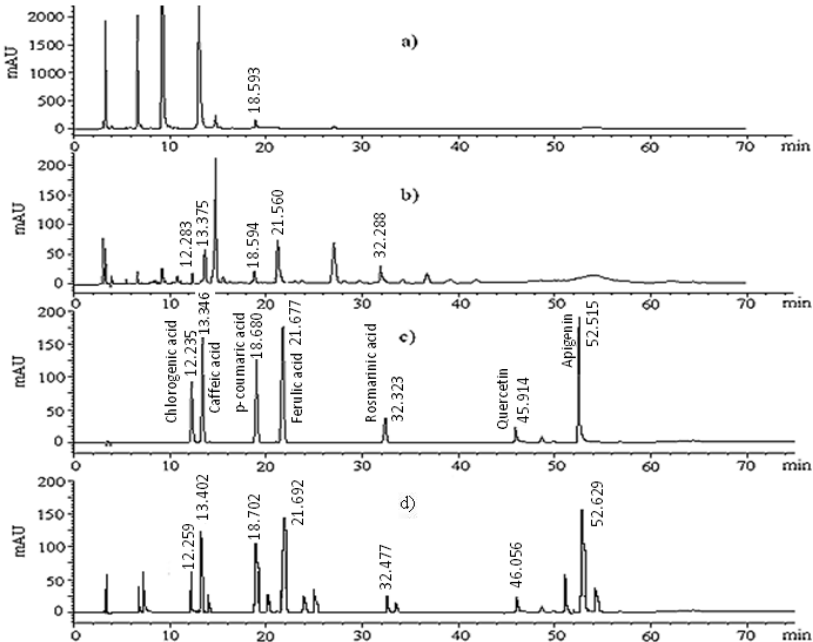
Figure 3. HPLC-DAD signals of ( a ) the acid-hydrolyzed methanolic extract from P. latifolia L. fruits obtained at 280 nm and ( b ) 330 nm, and ( c ) a standard mixture of phenolic compounds obtained at 330 nm and ( d ) the same standard mixture in ( c ) obtained at 330 nm after subjection to